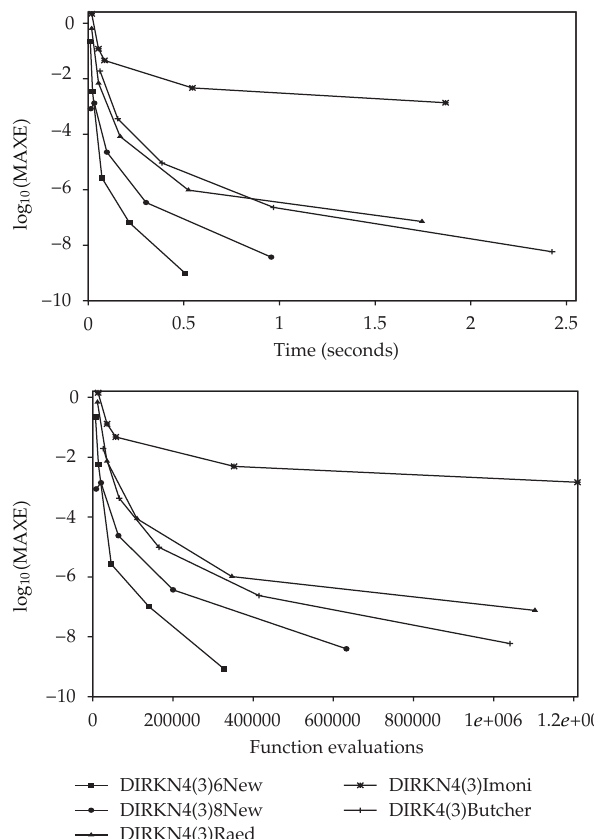
Figure 3: E ffi ciency curves for Problem